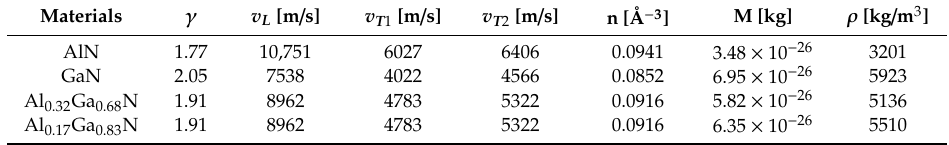
Table 1. Material parameters used for the theoretical models of the lattice thermal conductivity. Materials